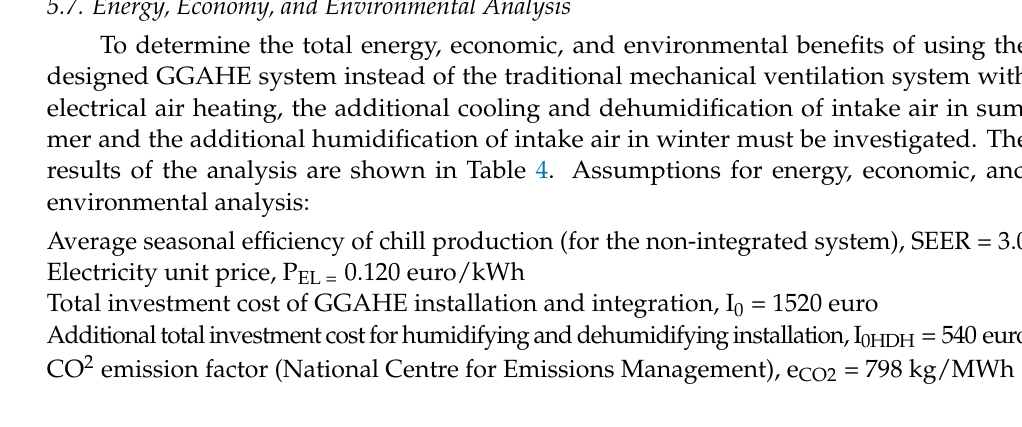
Table 4. Energy economy and environmental